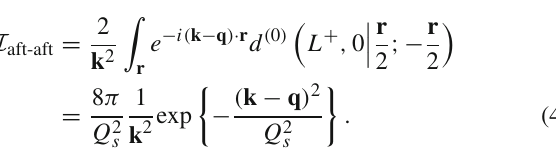
with the target on both sides of the cut. It